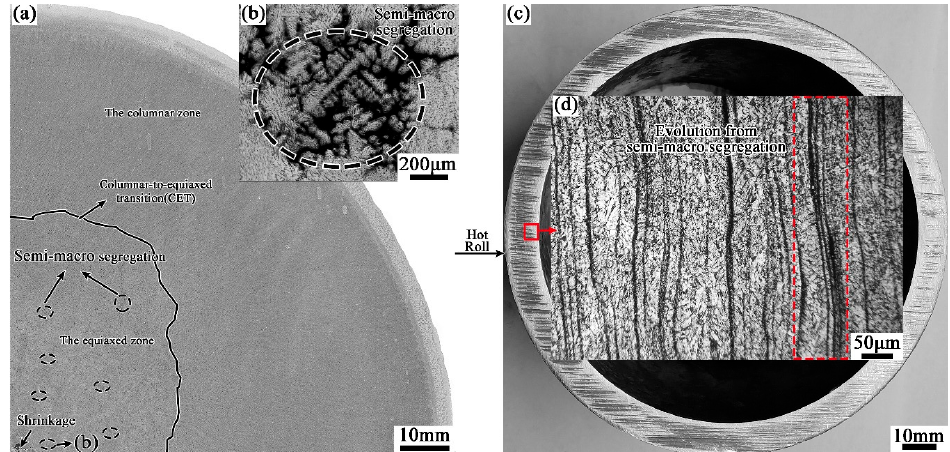
Figure 2. As-cast semi-macro segregation ( b ) in round casting ( a ) and its evolutionary banded defects ( d ) in tube wall ( c ).